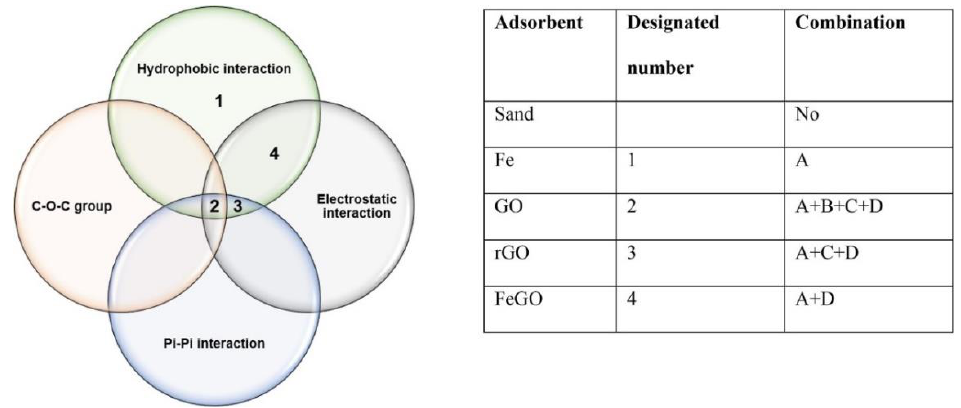
Figure 3. Venn-diagram showing common microcystin-LR (MC-LR) interaction factors for different coated sand adsorbents. A: hydrophobic interaction, B: epoxy/ether group (C-O-C), C: pi-pi interaction, D: electrostatic interaction, reproduced from ref. [95] with permission from Elsevier.